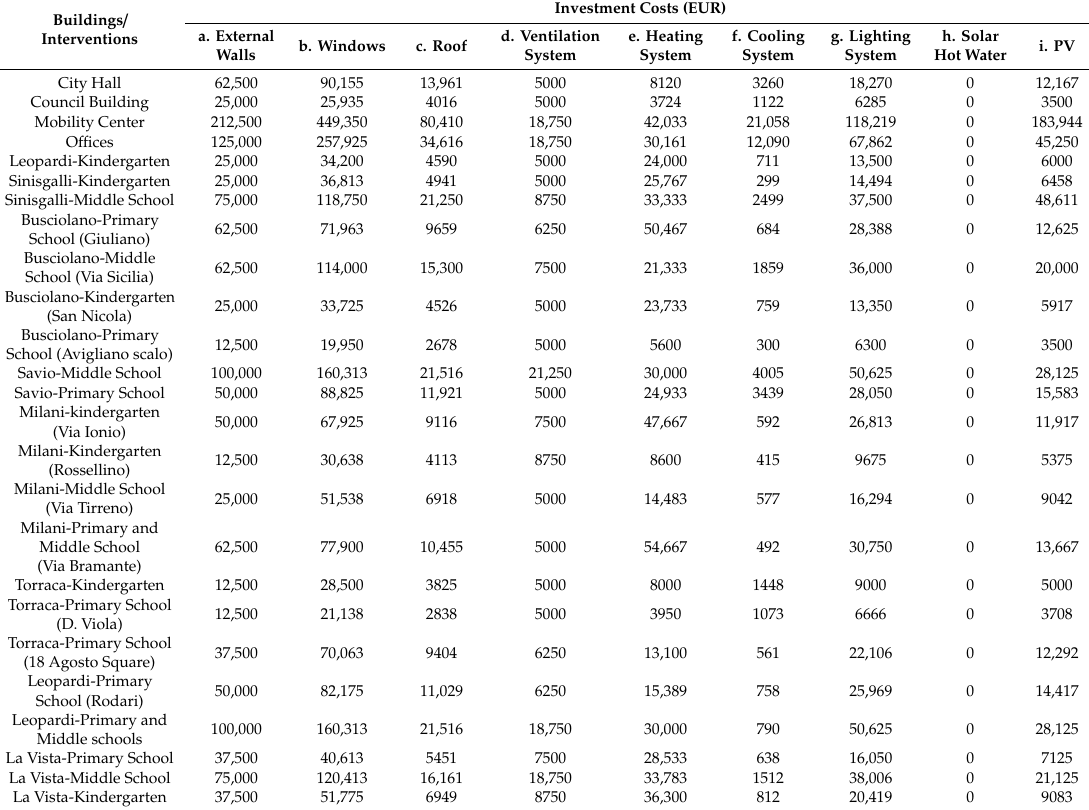
Investment costs of energy e ffi ciency measures and renewable technologies for the selected